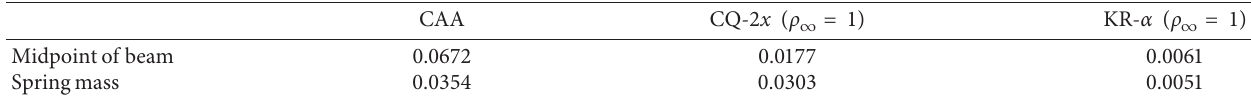
Figure 37: Midpoint vertical deflection of the beam. Table 5: Maximum deflection error ratios in Example 4.